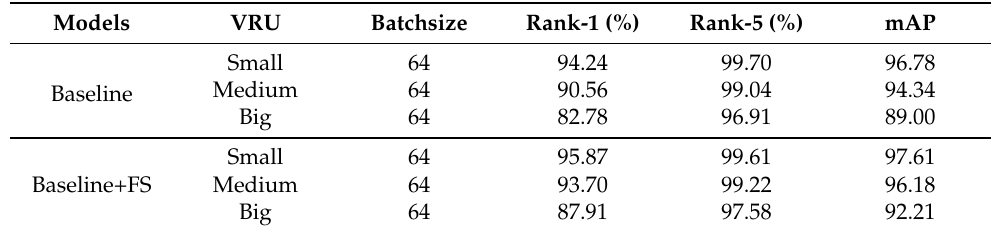
Table A6. Test results of the baseline model and the full-scale model with input batch 64 on the VRU dataset.